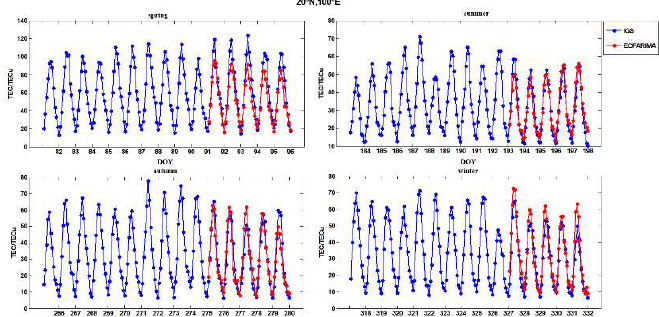
Figure 2 (20°N,100°E) VTEC value of grid node